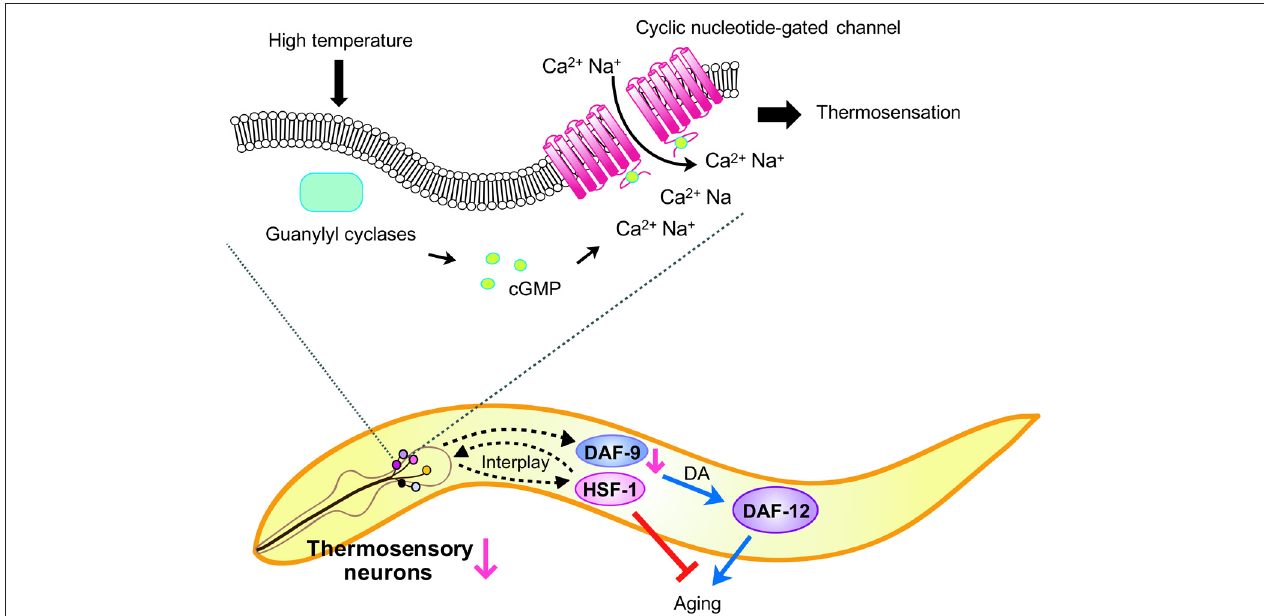
FIGURE 4 | Model of C. elegans lifespan control by thermosensory AFD neurons. Increased ambient temperature is perceived by AFD thermosensory neurons. Although the exact mechanism for thermal cue perception is not understood, upon sensing temperature elevation, G protein signaling promotes cyclic GMP production and facilitates the influx of Ca 2 + and Na + cations by opening cyclic nucleotide-gated channels (CNGs). The signal perceived by the thermosensory neurons is transmitted to downstream effectors, such as DAF-12/NHR and heat shock factor 1 (HSF-1), via intercellular (cell-nonautonomous) signaling. Impairment of AFD